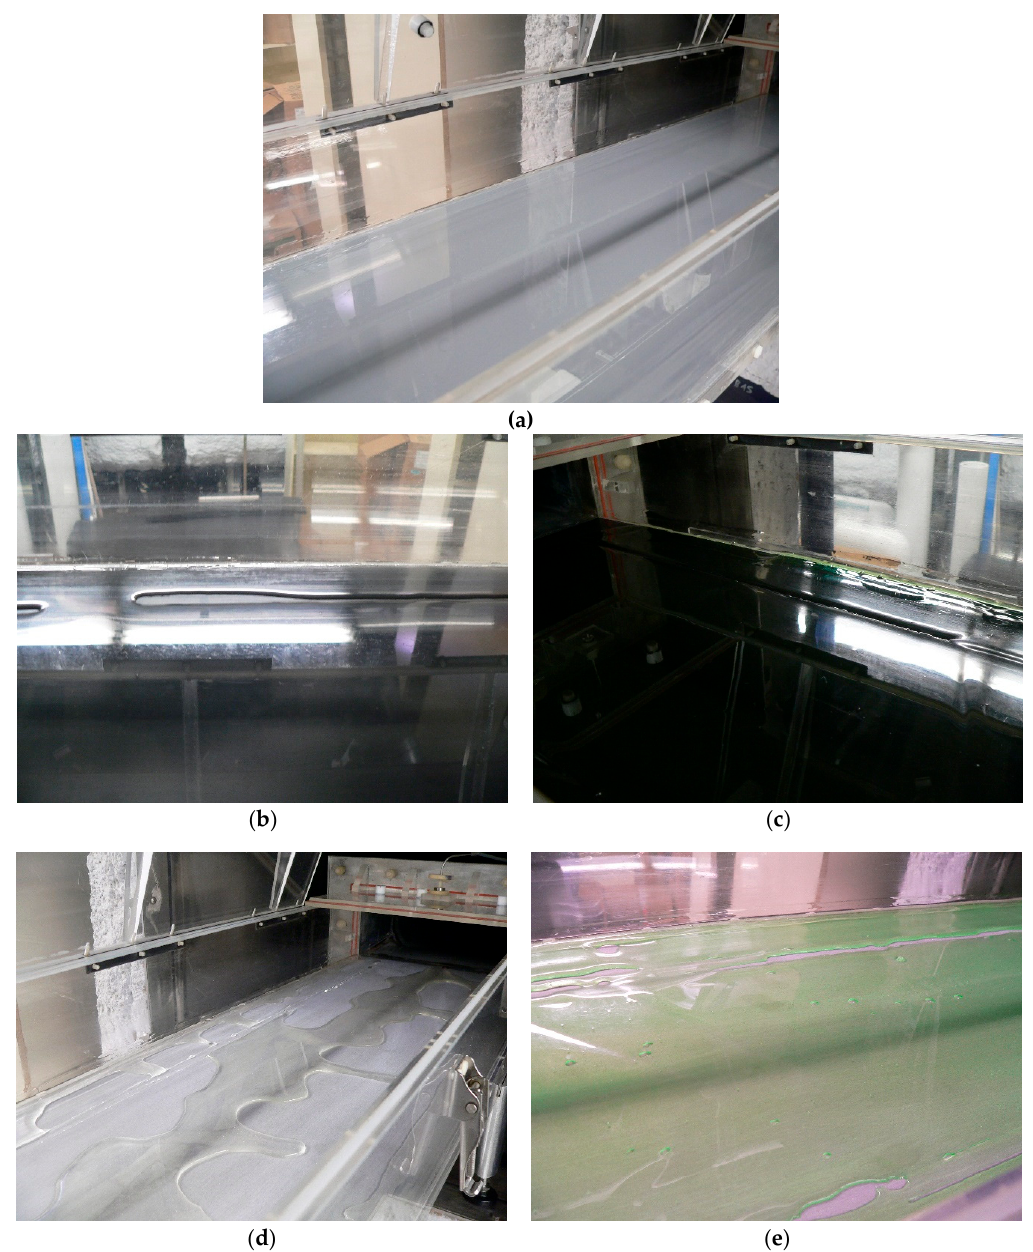
Figure 13. Spreading of fluid before the test ( a ) Ref. Fluid on epoxy, ( b ) Ref. Fluid on hydrophobic, ( c ) Fluid B on icephobic, ( d ) Ref. Fluid on Superhydrophobic 2, ( e ) Fluid B on Superhydrophobic 2.